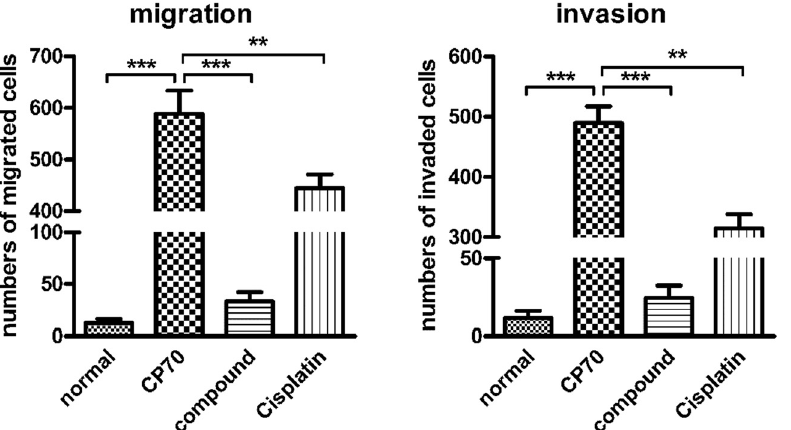
Figure 4: Reduced invasion and migration of the cancer cells of CP70 ovarian after treated with the compound. The CP70 ovarian cancer cells were inoculated into 6 well plates and carried out compound treatment. The migration and invasion of cancer cells of CP70 ovarian were determined with transwell assay. **means p < 0.01, ***means p <